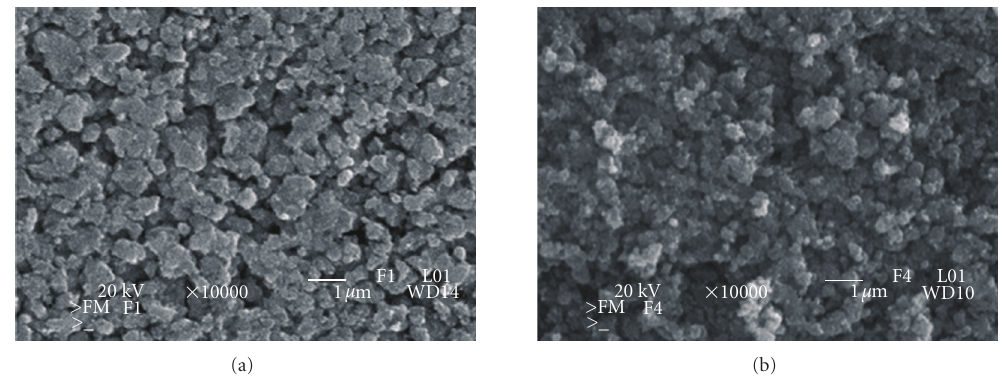
Figure 5: SEM of (a) TiO 2 and (b) TiO 2 -WO 3 -3% heat treated at 600 ◦ C.